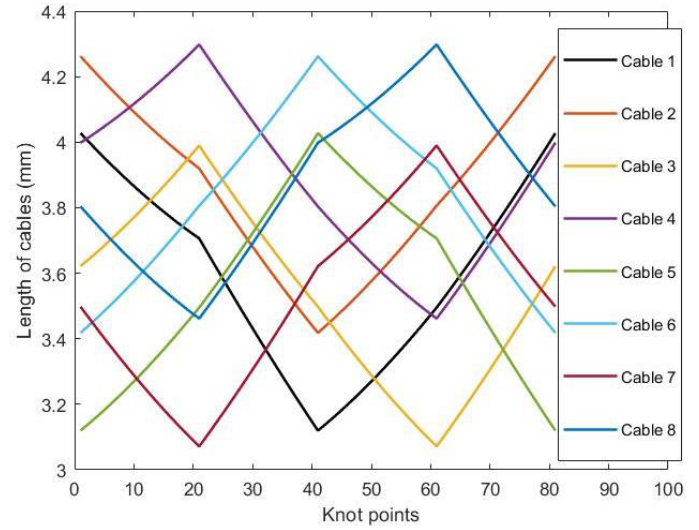
Figure 17. Joint trajectory of the 0.8 m square interpolation.